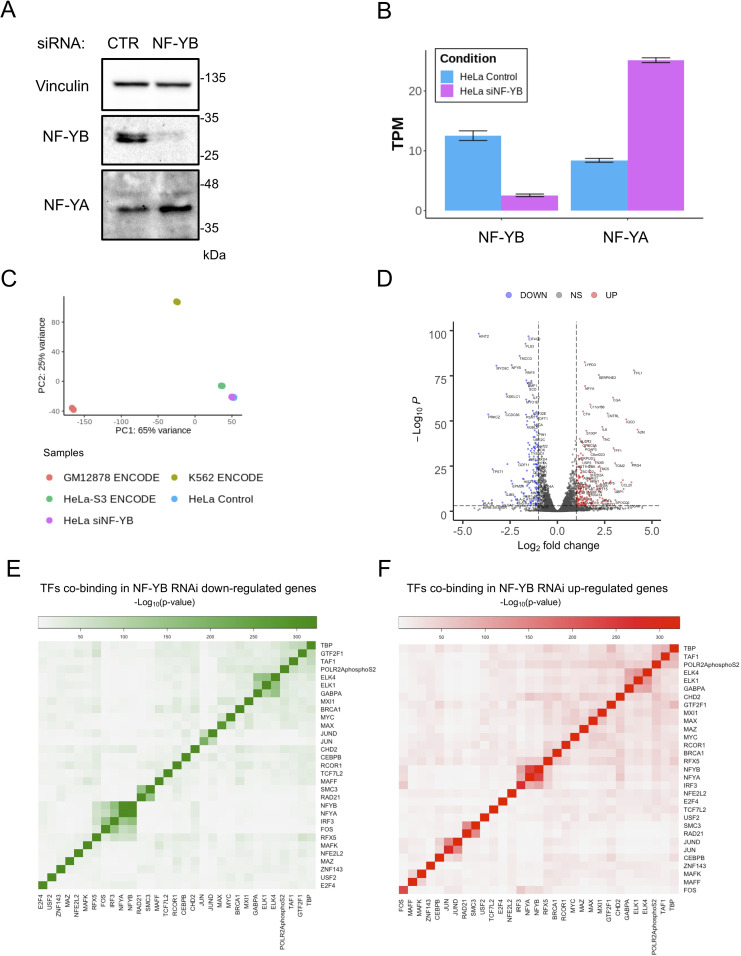
Analysis of mRNA expression data of HeLa cells after NF-YB RNAi A.Western Blot of NF-YA and NF-YB in control (CTR) and NF-YB knockdown HeLa cells. B. Barplot of NF-YB and NF-YA mRNA expression from RNA-seq dataset. C. Principal Component Analysis (PCA) of ENCODE RNA-seq data together with our HeLa cell line expression data after silencing of NF-YB. D. Volcano plot depicting differentially expressed genes of RNA-seq data after siNF-YB in HeLa cell line. E. Heatmap of clusters of TFs that bind promoters of down-regulated genes (green scale). F. Same as E for up-regulated genes (red scale).